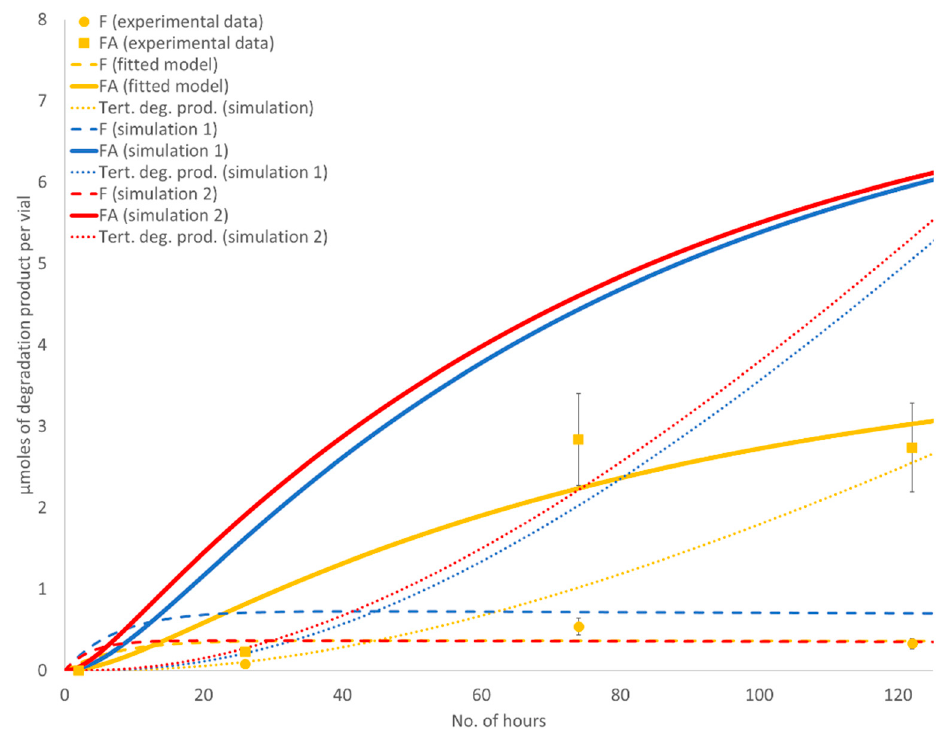
Figure 5. Experimental data, fitted model, and simulated model for polyethylene glycol (PEG) degradation kinetics. Experimental data for formaldehyde (yellow circles) and formic acid (yellow squares) concentrations in PEG only degradation samples, fitted model (yellow lines), and two simulations (blue lines—k 1 was increased by 2-fold and red lines—k 1 and k 2 , were increased by 2-fold) are depicted. Time in hours is presented on the x axis, µmoles of degradation product per vial are presented on the y axis. Abbreviations: Formaldehyde (F); formic acid (FA); hypothetical tertiary degradation product (tert. deg. prod.).